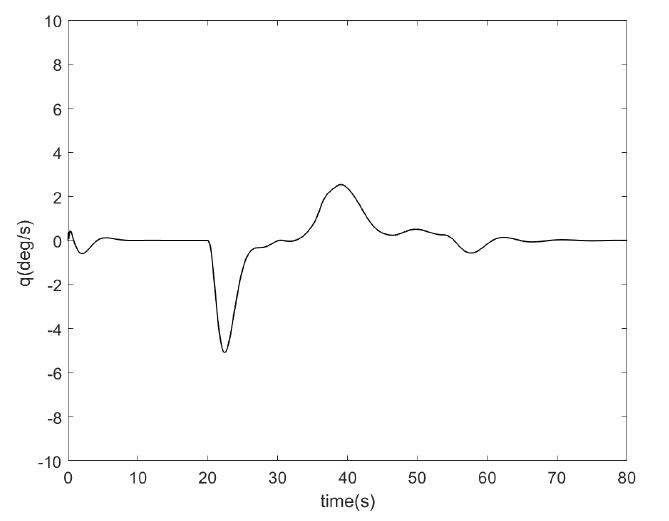
Figure 12. The time evolution of pitch change rate.